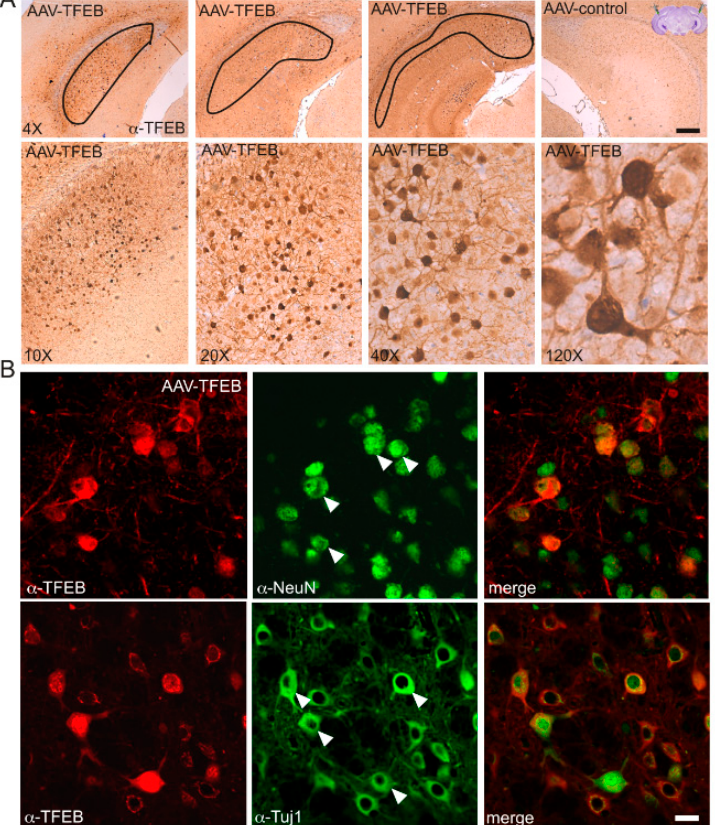
Figure 4. The overexpression of TFEB after stereotaxic injection of AAVs in the subiculum of 3-month-old mice leads to neuronal and nuclear TFEB staining. Immunostaining was performed in 8-month-old mice and revealed with HRP-conjugated antibodies and DAB ( A ) or with fluorescence-conjugated antibodies ( B ). ( A ) Images show the expression of TFEB at different levels of the subiculum in one of the AAV-cmv-FLAG-TFEB mice and the absence of staining in an AAV-cmv-GFP injected mouse (right panel). High magnification images show that the expression of TFEB is localized mainly in cells with the morphology typical of neurons and with a subcellular localization in both cytoplasm and nuclei. ( B ) Images show co-immunostaining of TFEB (red) and NeuN or Tuj1 (green) indicating that nearly all TFEB expression was localized to neurons. Scale bar: 150 µm (4×), 60 µm (10×), 30 µm (20×), 15 µm (40×) and 5 µm (120×) in ( A ) and 10 µm in ( B ).